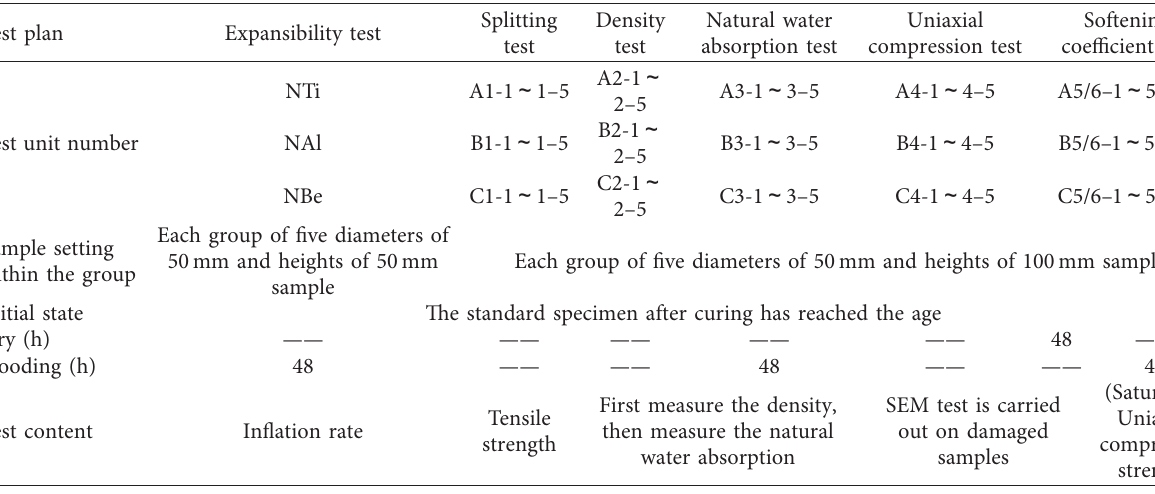
Table 4: Test schemes.